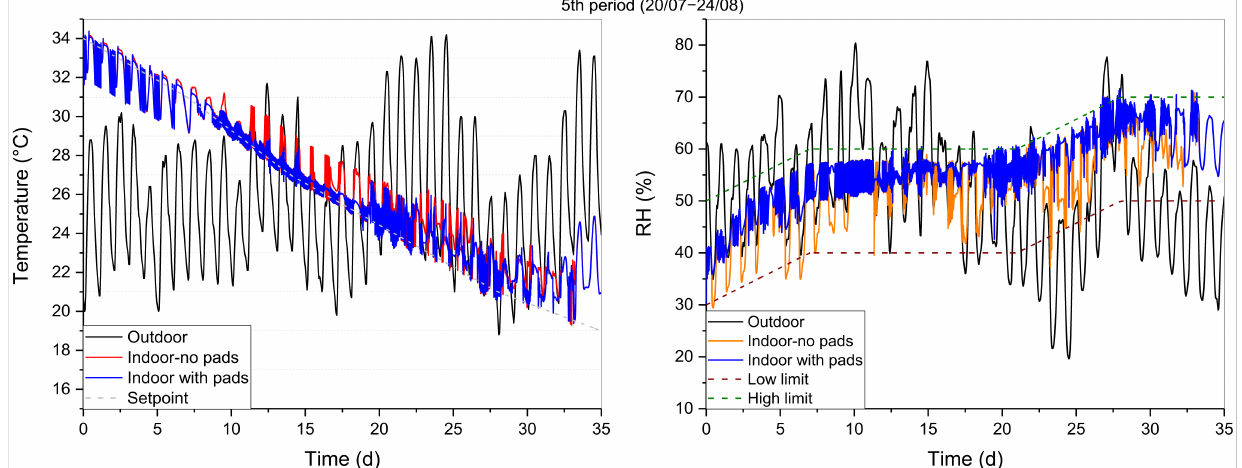
Figure 13. Temperature and relative humidity without and with evaporative pads for the 5th production period